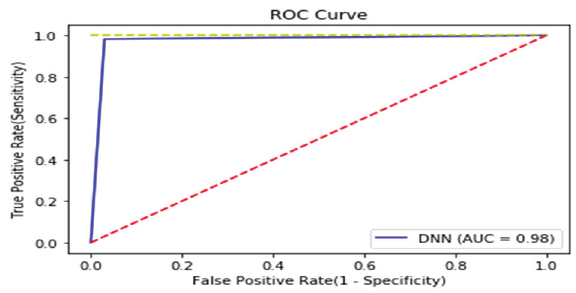
Figure 15. ROC curve of Linux binary.